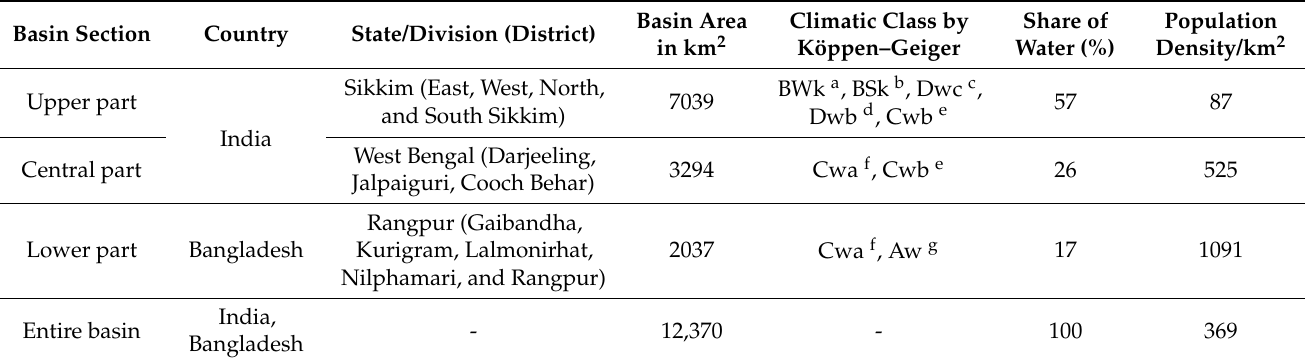
Table 1. Salient features of the Teesta river